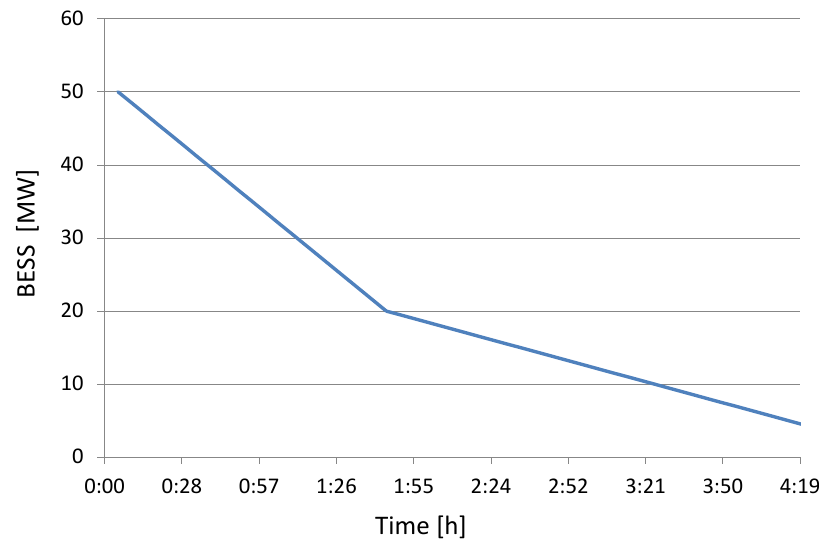
Figure 12. BESS resource output